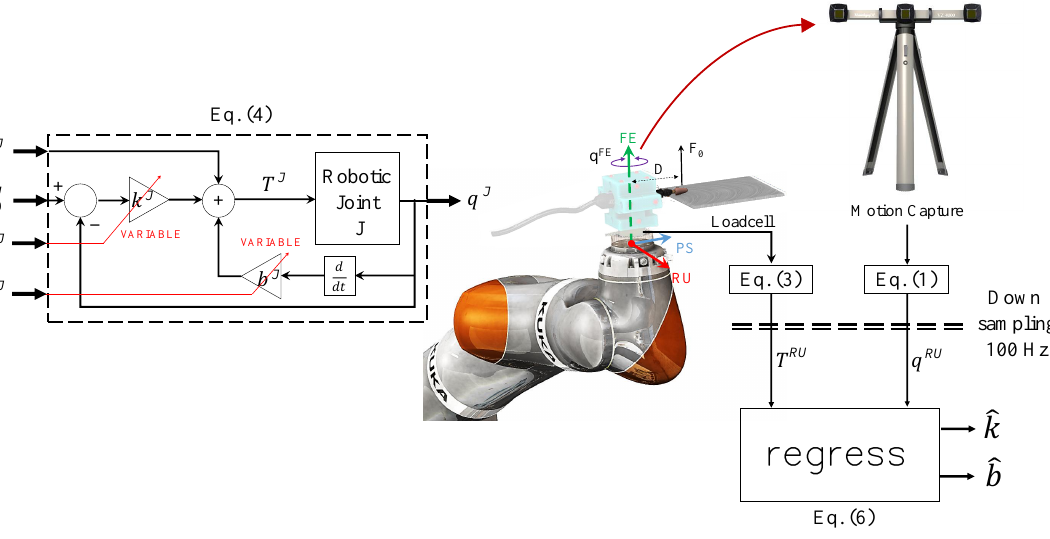
Figure 3. Method to estimate a robot stiffness and damping during polishing while moving sinusoidally. The top left corner shows a diagram of a torque-controlled robotic